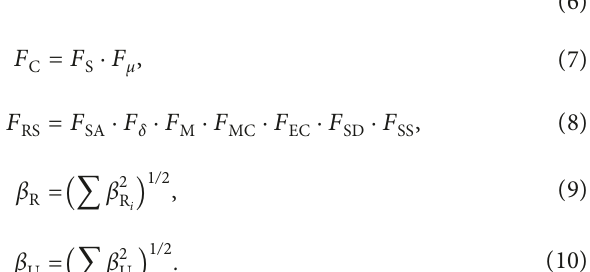
Figure 2: PWR nuclear power plant